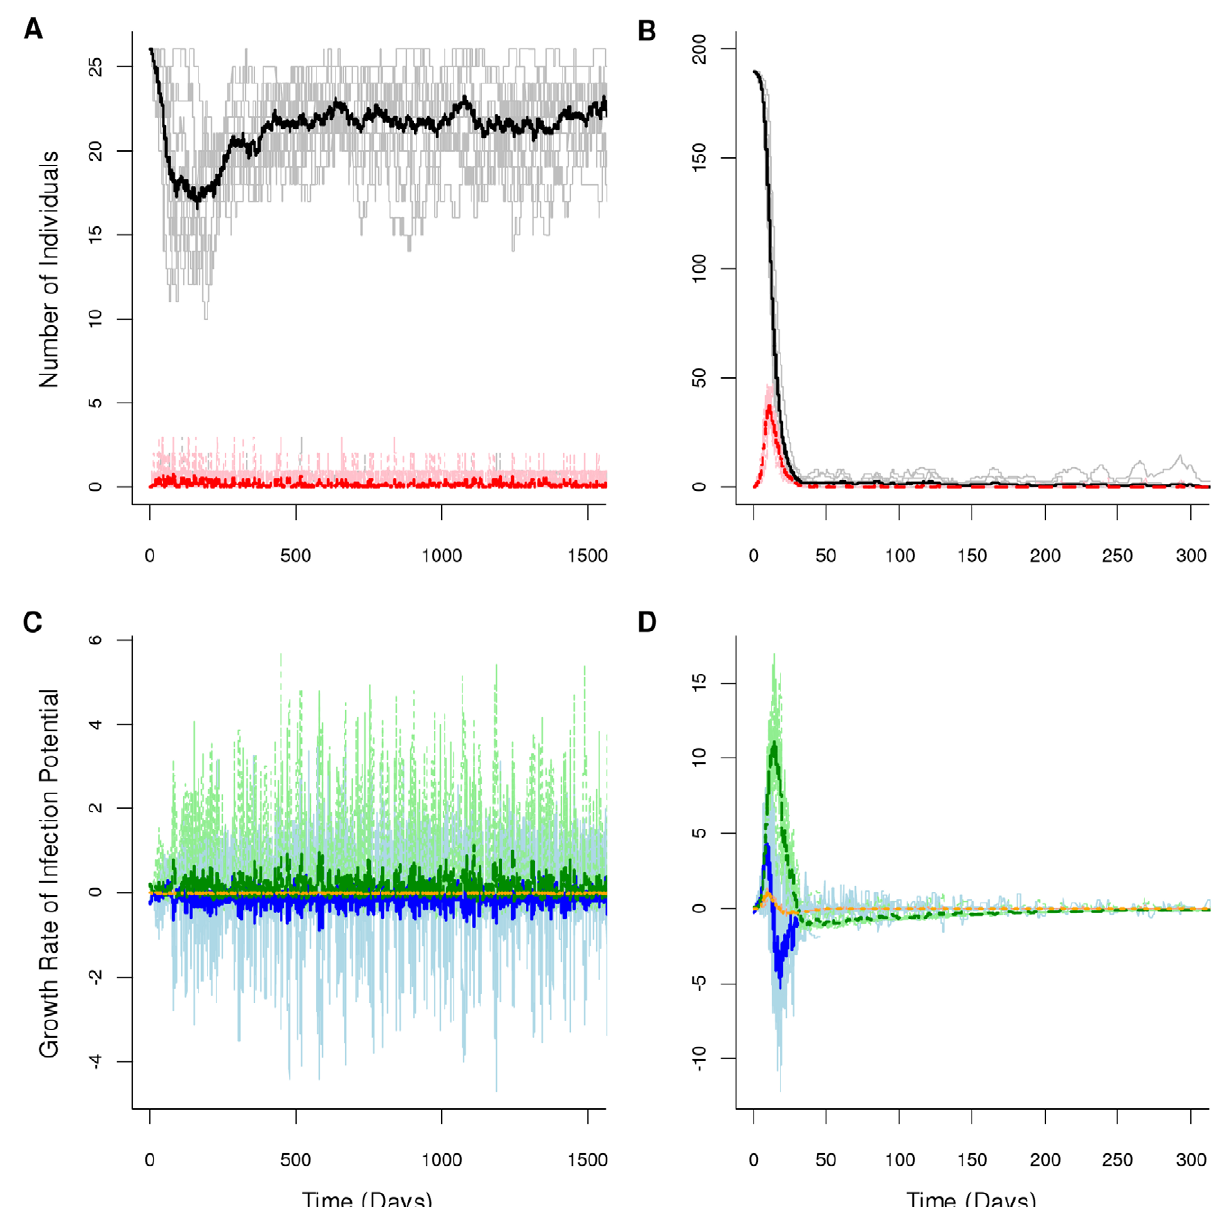
Figure 1. Enzootic and epizootic plague dynamics. Model behavior for given parameter values (Table 2) with light/bold lines giving results for independent model runs/average behavior. Total population size (gray/black) and number of infectious individuals (pink/red) are shown for the A) enzootic host and B) epizootic host. The growth rate of infection potential over time for the three transmission routes, booster-feed infections (light blue/blue), questing flea reservoir (light green/green), and carcass reservoir (light orange/orange) are shown for the C) enzootic host and D) epizootic host.